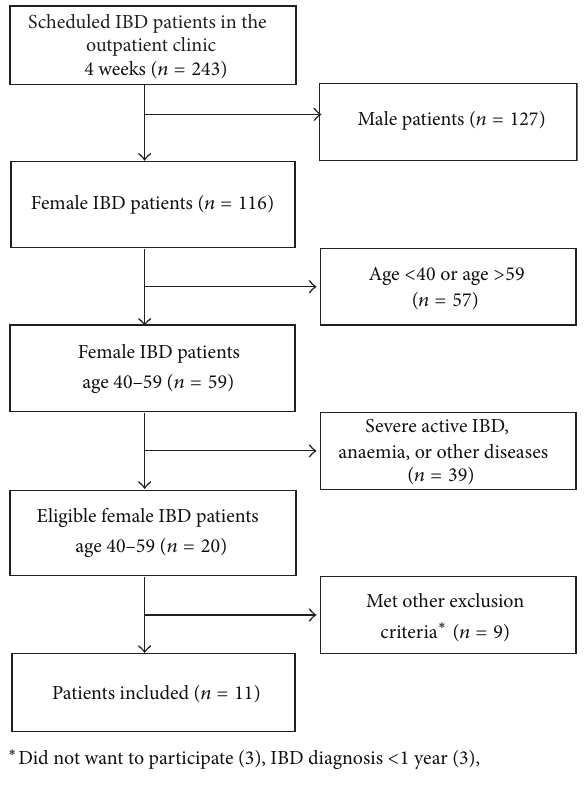
Figure 1: Patient